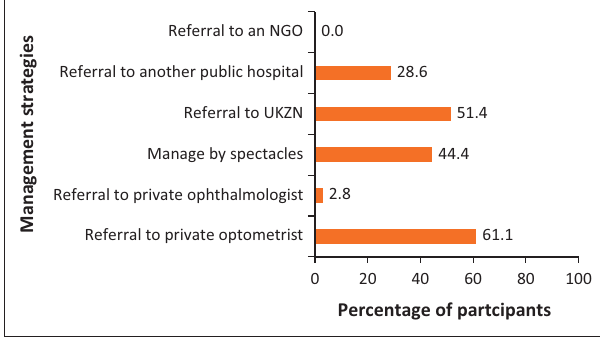
FIGURE 2: Management strategies of patients needing contact